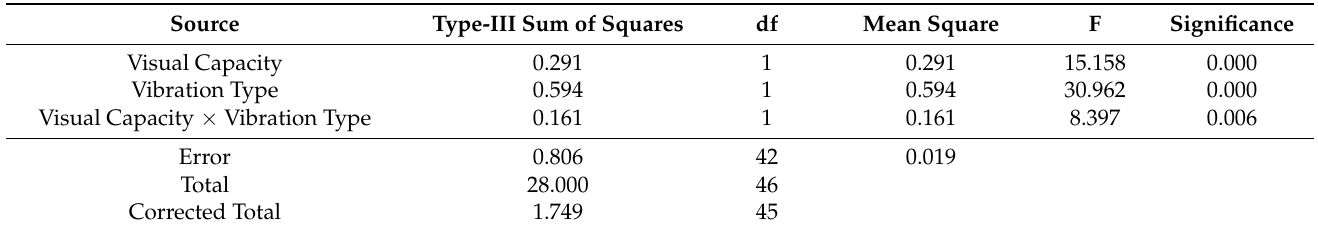
Table 5. Two-way ANOVA test of the recognition rate as a function of the visual capacity of the subjects and the vibration type